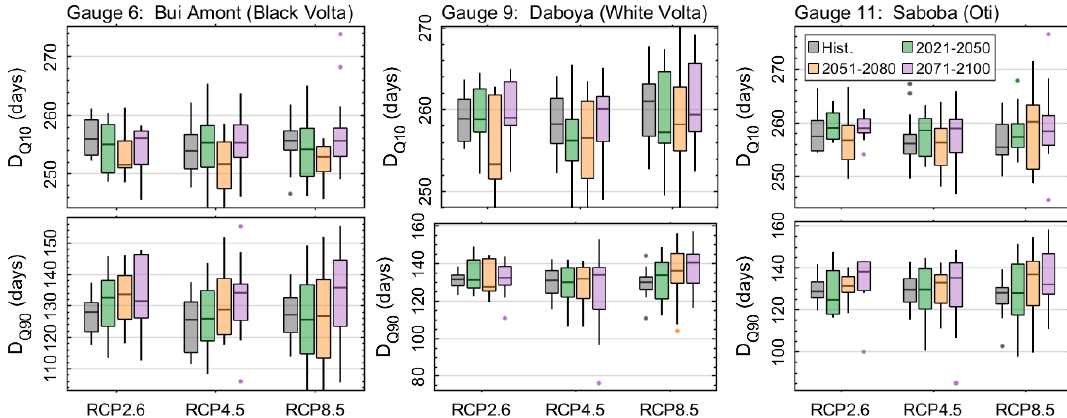
Figure 13. Mean Julian dates of occurrence ( D ) of annual high flows ( Q 10 ) and low flows ( Q 90 ) over the historical (1991–2020) and future periods in the major sub-basins of the VRB (Black Volta, White Volta, and